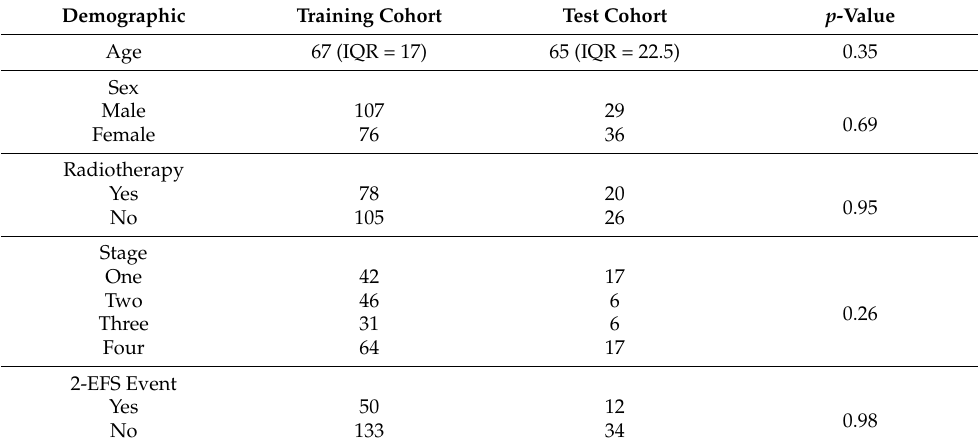
Table 2. Demographics of the training and testing groups.